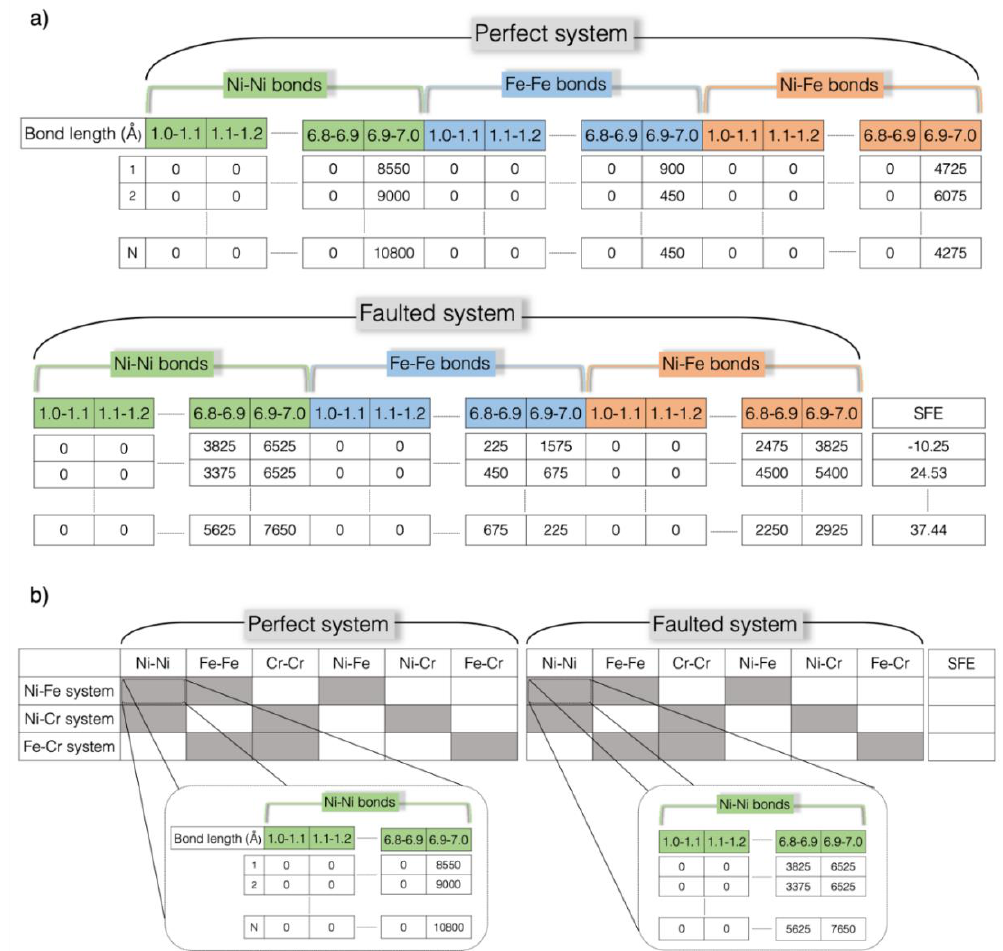
Figure 3. Representation of the data in the form of spreadsheet used to train the machine learning model to predict SFE of ( a ) binary alloys and ( b ) ternary alloys. In ( a ), separate spreadsheets are created for perfect and faulted structures. The bond lengths for each type of A-A, B-B, and A-B bonds are documented up to 7 Å and are binned at an interval of 0.1 Å. The number of bonds of each type under corresponding bond length are included. The resulting SFE for each structure is included into the spreadsheet. In ( b ), shaded boxes represent the bond information of a particular bond type, while empty boxes represent no information for that particular bond type. The zoomed-in view of a shaded box shows the bond length information used to train the model, similar to (a).